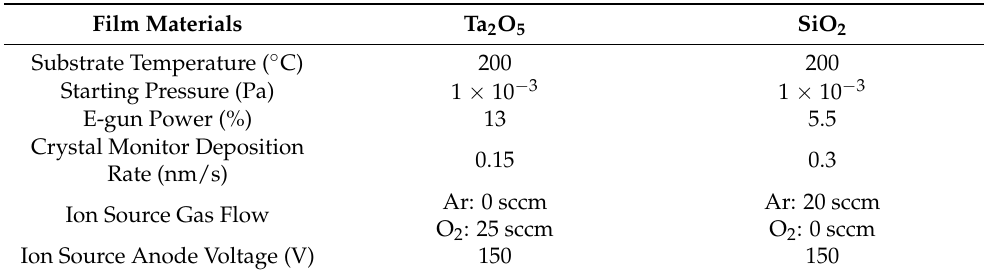
Table 1. Pertinent process parameters of Ta 2 O 5 and SiO 2